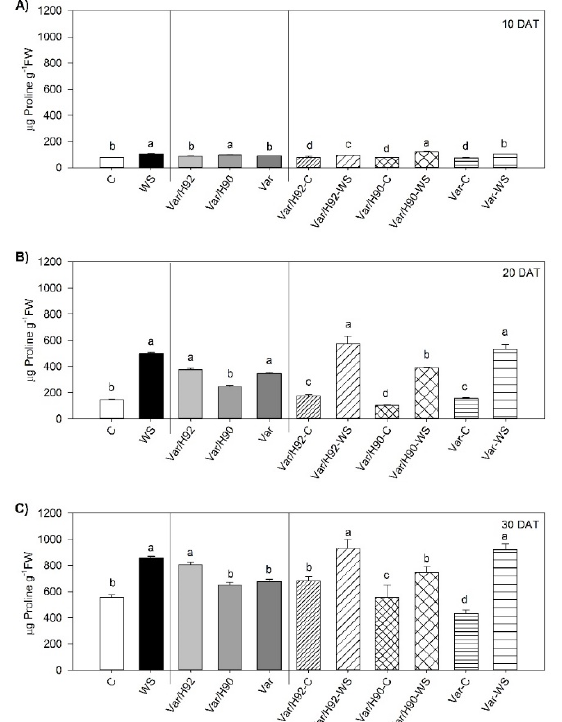
Figure 6. Proline content in the leaves of the ungrafted plants (Var, variety “Sueca”) and Var grafted onto H92 or H90 (Var/H92 and Var/H90) under the water stress (WS) or control conditions (C) at 10 ( A ), 20 ( B ), and 30 ( C ) days after treatment (DAT). Different letters indicate significant differences at p < 0.05 (LSD test) for each measurement time separately. Data are the mean of four replicates and the error bars belong to the standard deviation for each plant type and treatment combination.